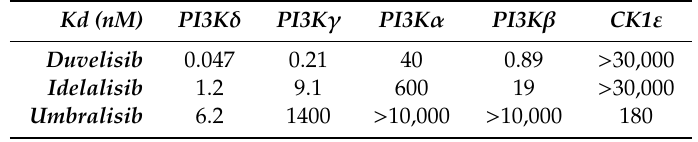
Table 2. Duvelisib and idelalisib are two PI3K inhibitors approved for therapy of B cell